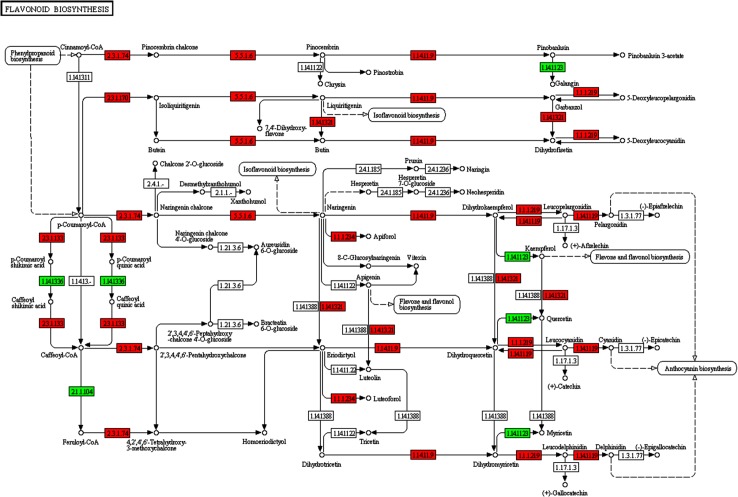
KEGG map of the DEGs involved in the flavonoid biosynthesis for the sweet basil leaf.Red boxes indicate overexpression in purple basil and green boxes overexpression in green basil.